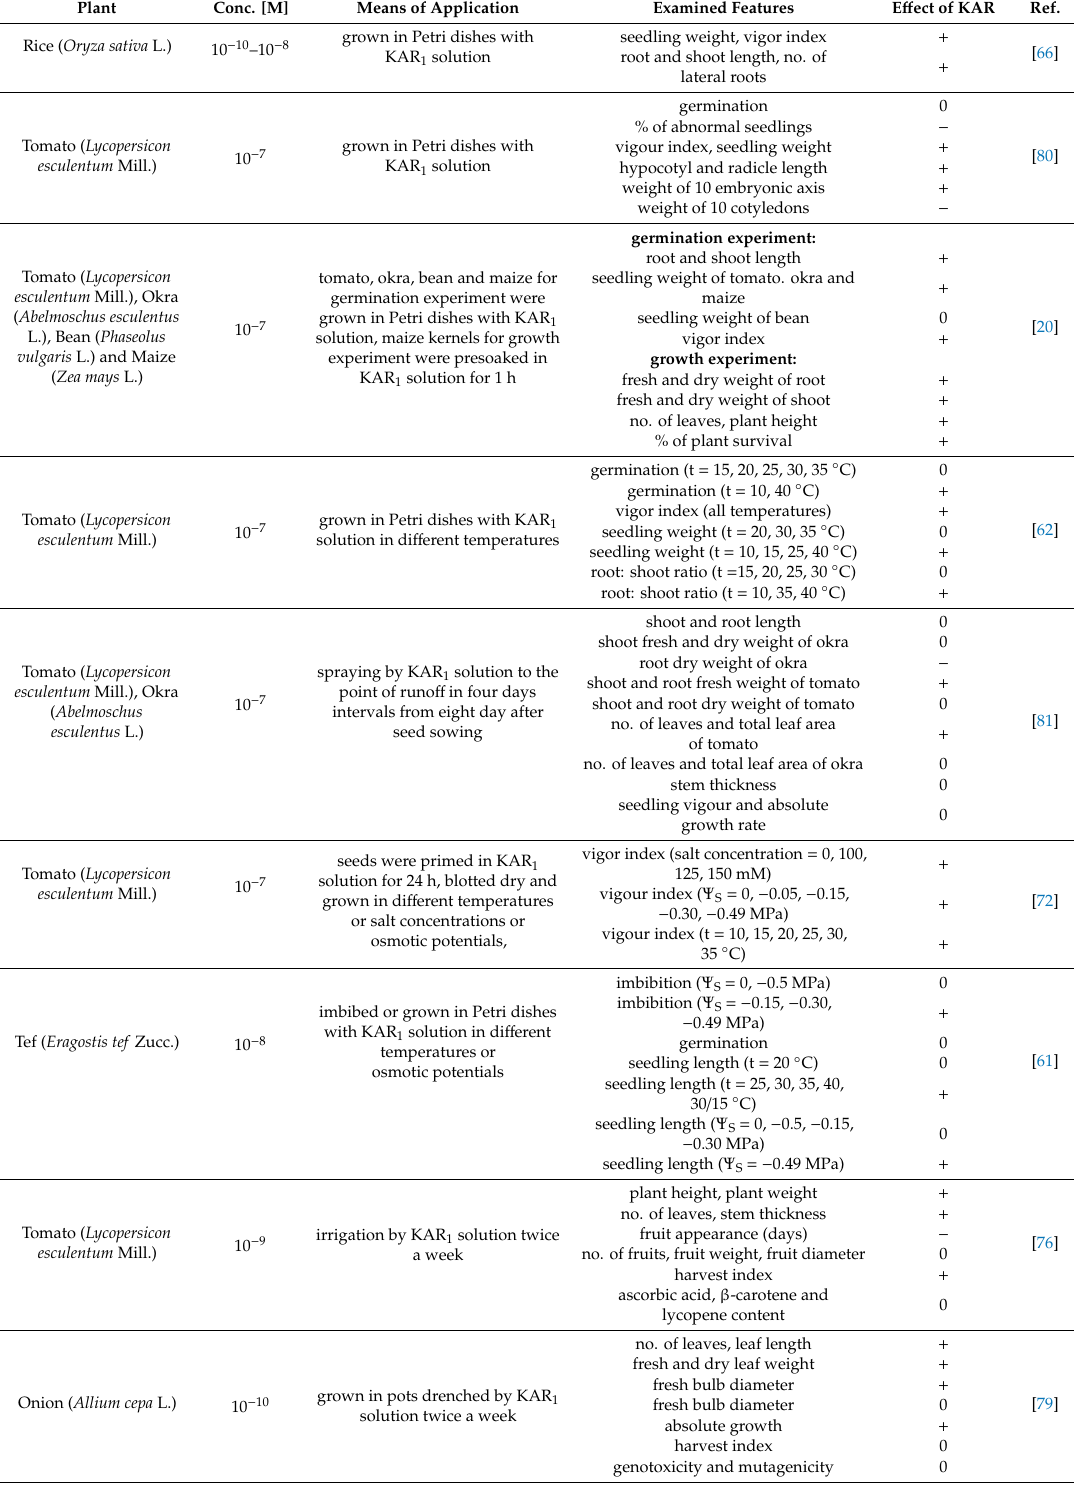
Onion ( Allium cepa